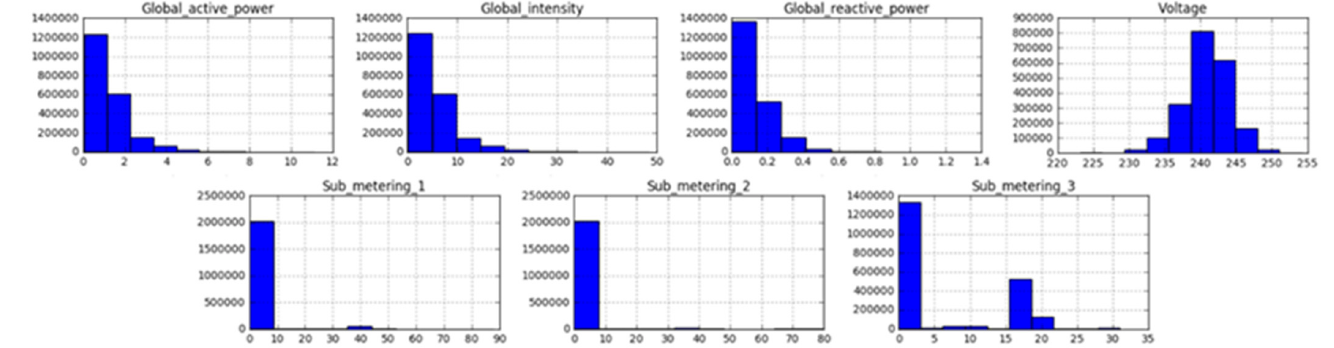
Figure 7. Histogram obtained for each variable in the dataset, given in minutes’ resolutions.